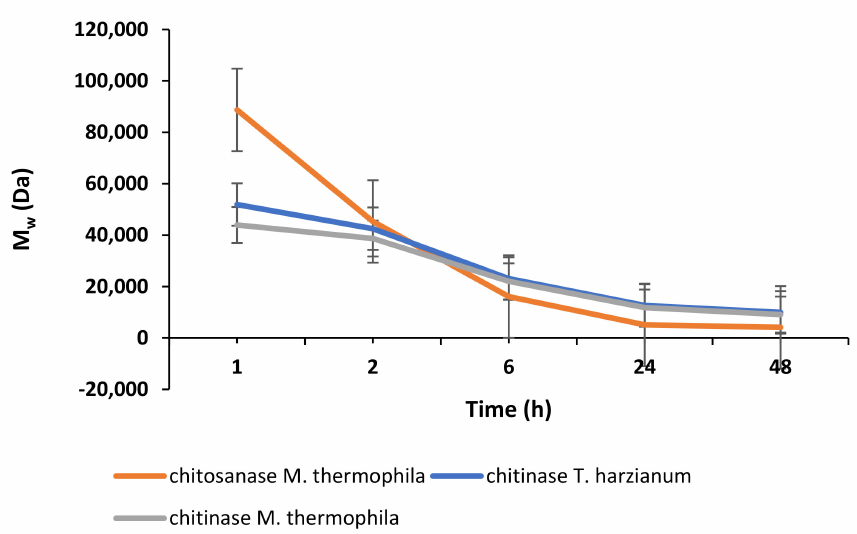
Figure 3. Kinetics of changes in the molecular weight of crab chitosan during enzymatic hydrolysis.